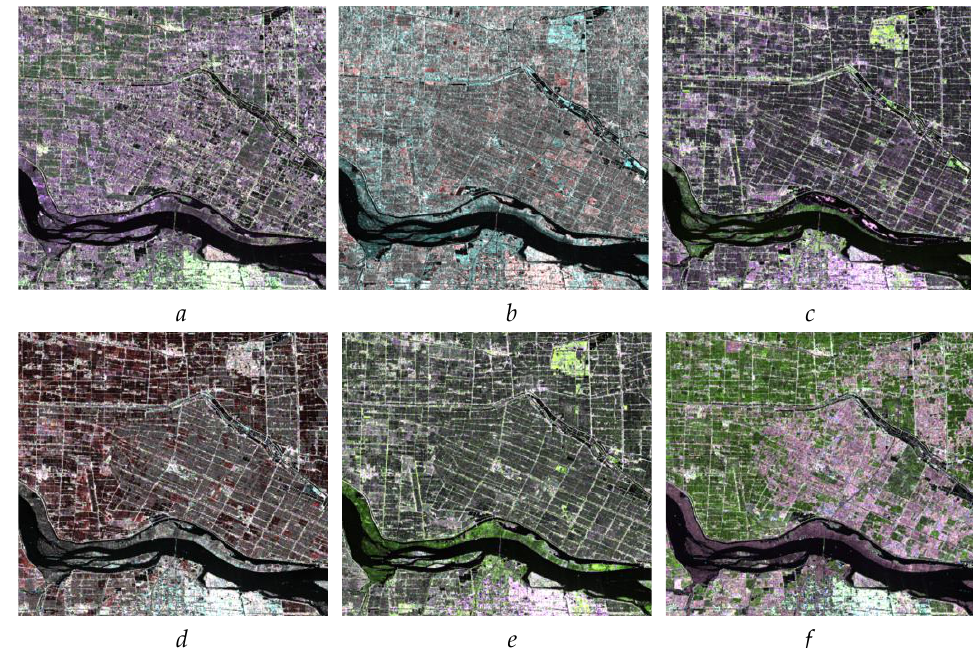
Figure 10. The color composite images: ( a ) C45 (red), LH (green), and RR (blue) on June 12; ( b ) CL (red), LL (green), and RR (blue) on July 30; ( c ) CL (red), LL (green), and RL (blue) on 23 August; ( d ) C45 (red), LV (green), and RV (blue) on September 16; ( e ) CL (red), LL (green) and RL (blue) on October 10; ( f ) C45 (red), LH (green) and RV (blue) on 3 November.